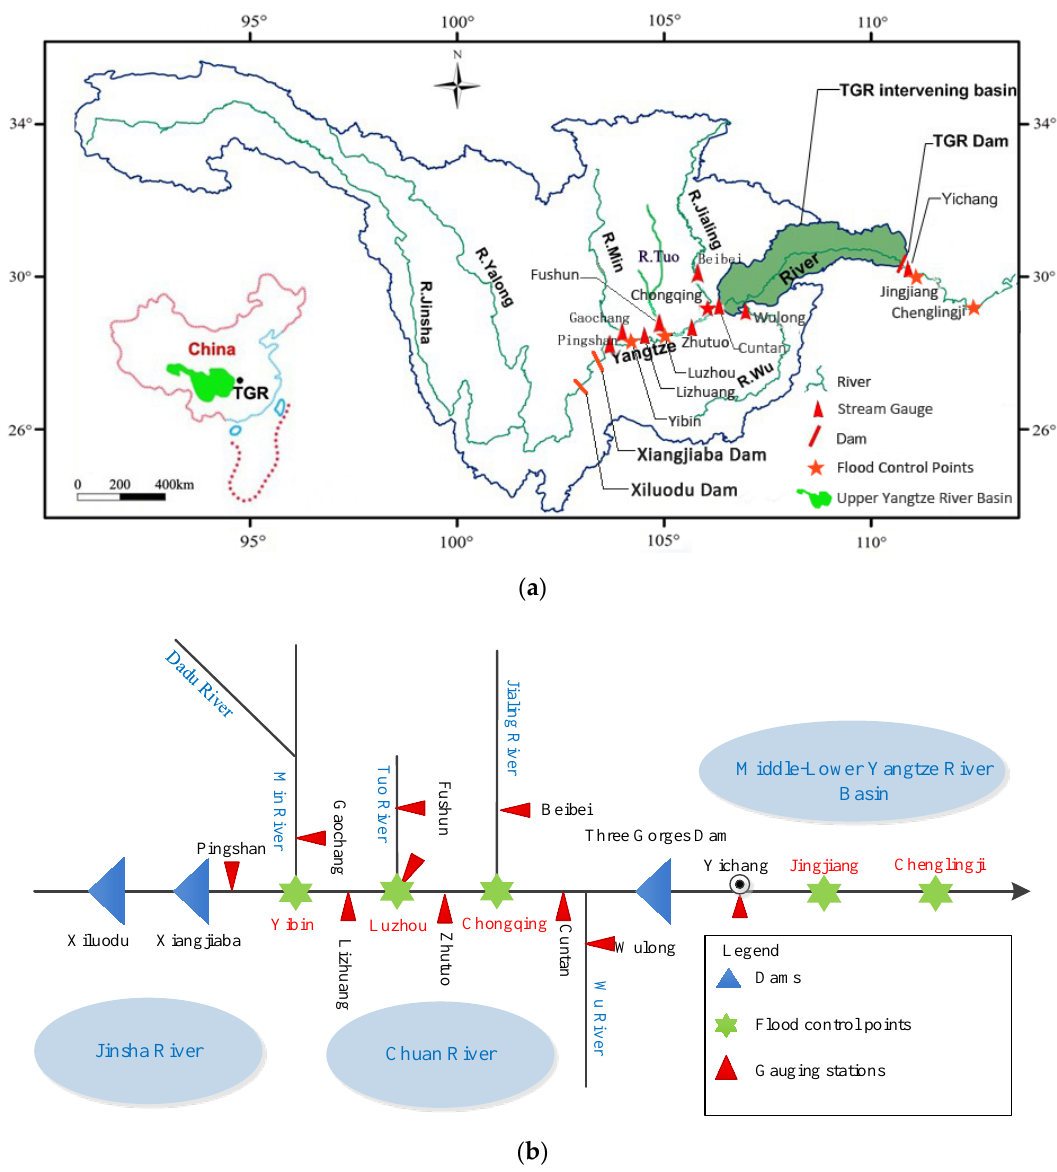
Figure 3. Locations of the dams, flood control points and gauging stations in the Yangtze River Basin. ( a ) The upper Yangtze River Basin; ( b ) skeleton of the upper Yangtze River Basin.